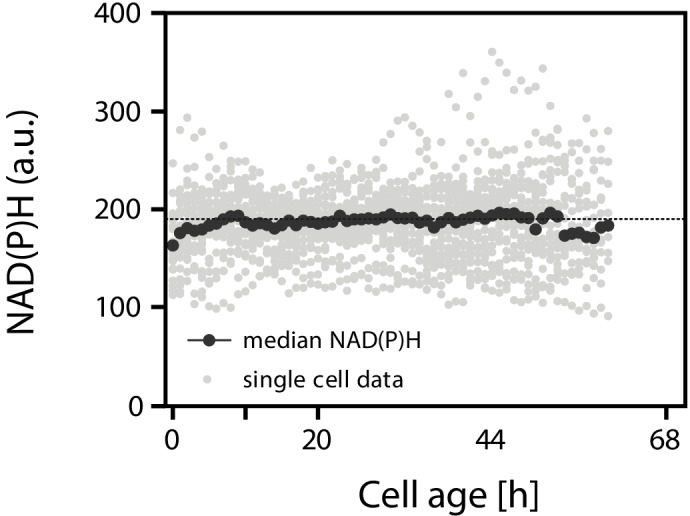
The intracellular NAD(P)H concentration remains constant with cell age.Individual cells of Saccharomyces cerevisiae were tracked in a microfluidics device and fluorescence images were recorded throughout their whole lifespan. The NAD(P)H concentration was inferred from the acquired autofluorescence (Papagiannakis et al., 2017). Assuming that this measurement mostly reflects the NADH concentration, and assuming that there is a Sirtuin inhibiting effect of NADH, then this effect would be constant through age.